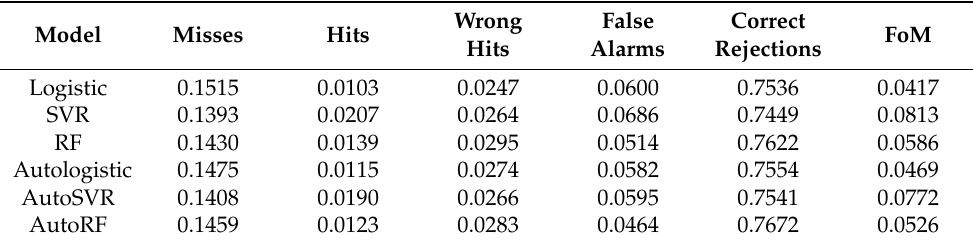
Table 4. Three-dimensional approach and FoM of different models in 2017.